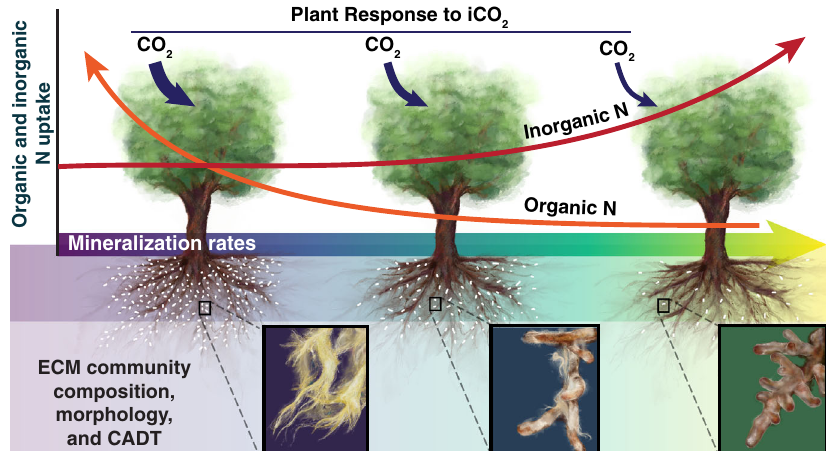
Fig. 1 Hypothesized contribution of different nitrogen (N) forms to tree growth (red and orange lines; y-axis) and tree responses to historic increases in CO 2 (iCO 2 ). These responses occur along a gradient of varying supply rates of inorganic N (net N mineralization rates: x-axis). Dark blue arrows show the relativized fertilization response (arrow width) to iCO 2 . ECM fungal community composition, morpho-traits, and community aggregated decay traits (CADT) estimated using metagenomic approaches, are hypothesized to vary with soil inorganic N availability. Note hypothesized turnover in the dominance of ECM taxa with extra-radical rhizomorphic hyphae and long-and medium-distance exploration morphologies. White speckles on roots depict hypothesized relative abundance of ECM root-tips. Illustration by Callie R. Chappell, with permission from Reinhard Agerer.